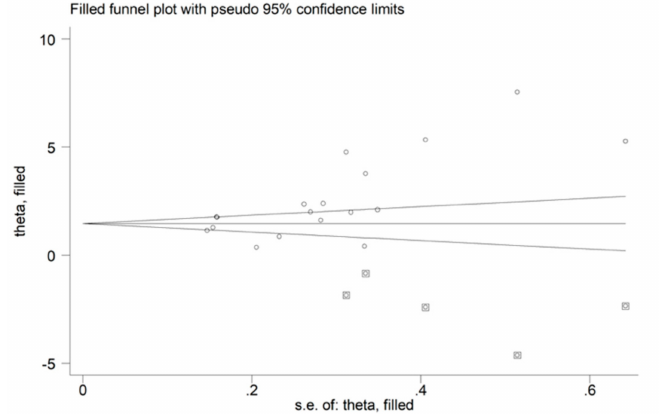
Figure 4. Funnel plot of ischaemia-modified albumin concentrations in patients with acute ischaemic stroke and controls after “trimming-and-filling”. Dummy studies and genuine studies are represented by enclosed circles and free circles,